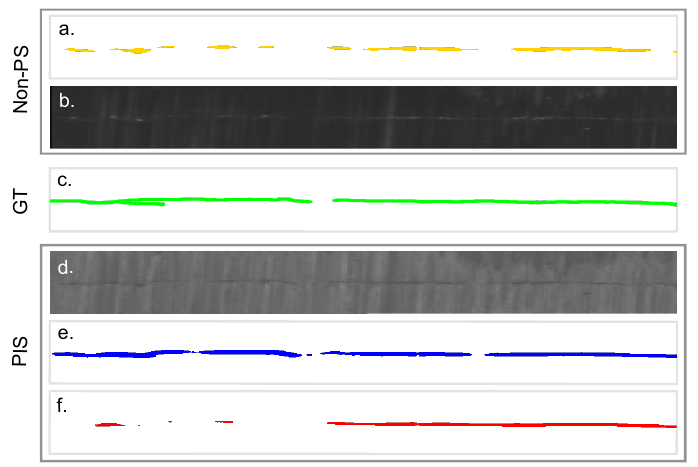
Figure 5. Qualitative comparison of tenuous crack detection performance based on a 5.05 × 19.15 mm patch (rotated). Ground-truth annotation mask (middle, c ), PIS data and results (bottom, d – f ), and non-PS image and result (top, a , b ). Only the CNN trained on PIS-PS data detected all perceivable sections of the crack ( e